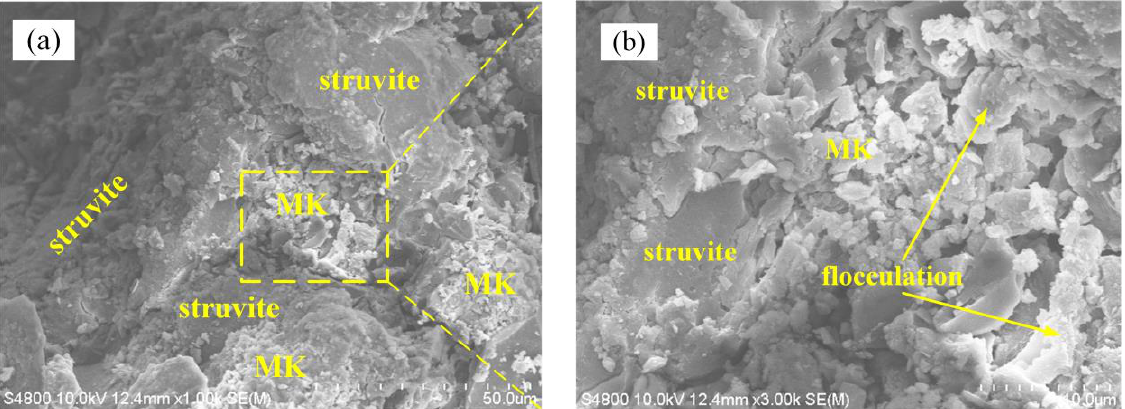
Figure 23. SEM microstructure of the MPC with the addition of MK at 28 d: ( a ) 1000 magnification, ( b ) 3000 magnification.